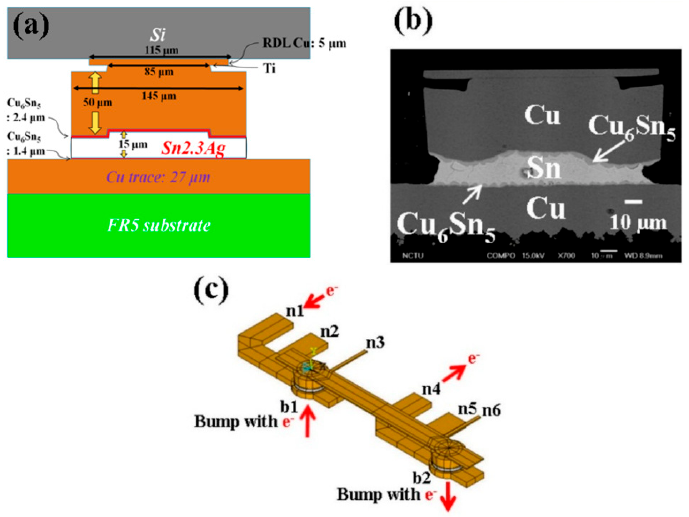
Figure 1. ( a ) Schematic of the flip-chip solder joints with Cu column UBM. The redistribution layer (RDL) on the Si chip is 5- μ m thick Cu. ( b ) Cross-sectional SEM images. ( c ) Layout for electromigration (RDL) on the Si chip is 5- µ m thick Cu; ( b ) Cross-sectional SEM images; ( c ) Layout for electromigration tests and four-point structure for measuring bump resistance. tests and four-point structure for measuring bump